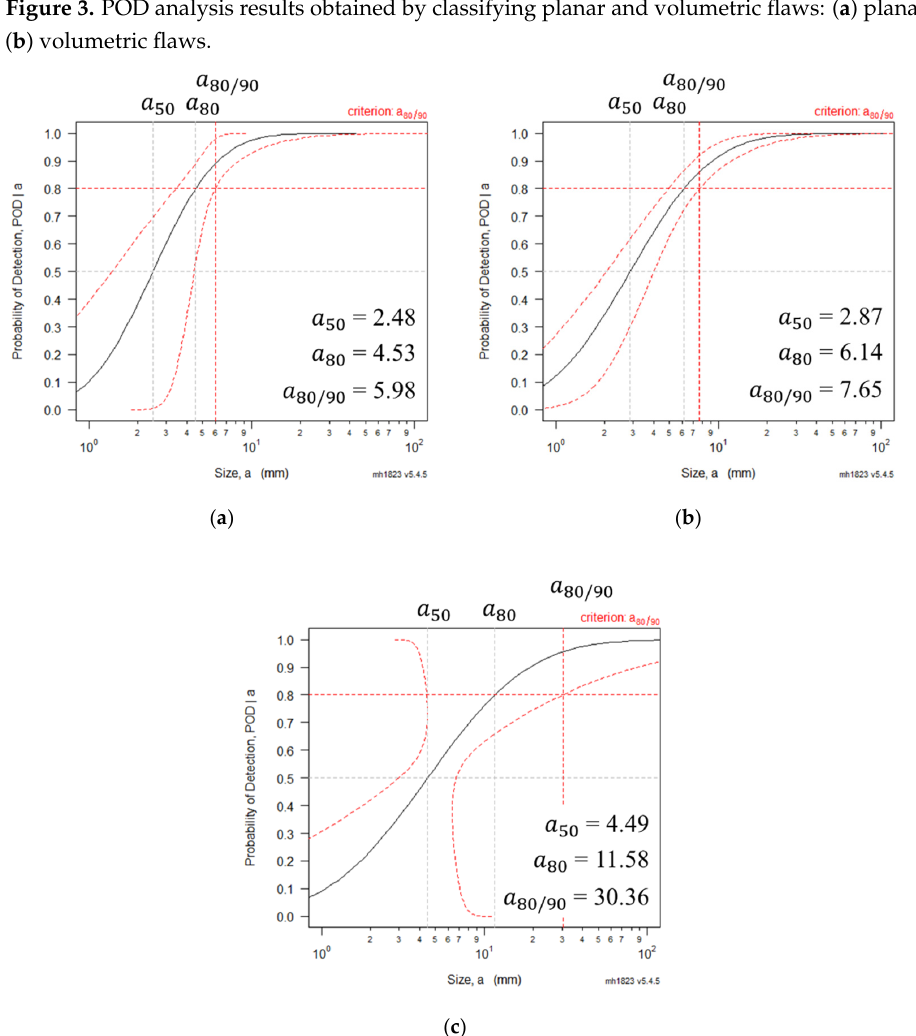
Figure 4. POD analysis results obtained by dividing the welds according to the materials: ( a ) Ferritic steel welds (SA210Gr.A1); ( b ) Austenitic stainless steel welds (TP304H); ( c ) Dissimilar metal welds (SA210Gr.A1 + TP 304H).